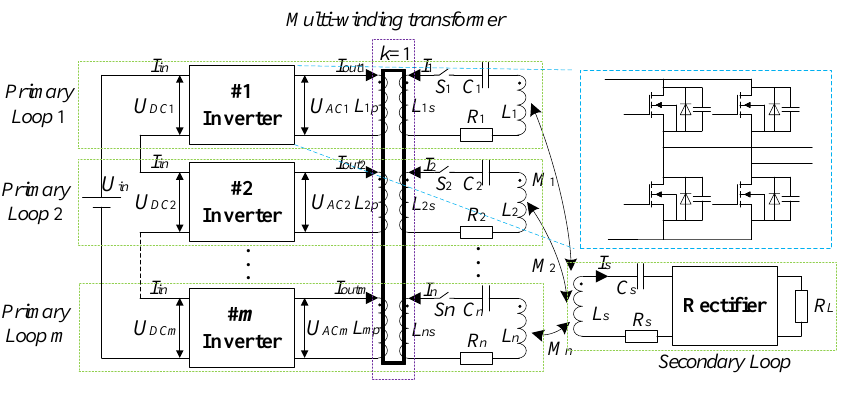
Figure 2. System equivalent circuit